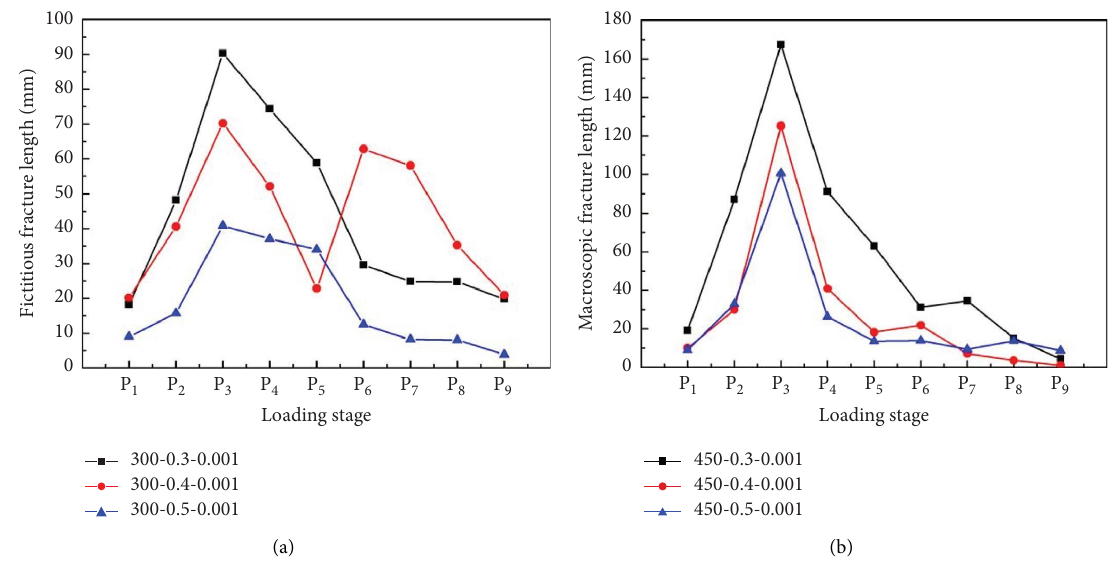
Figure 12: Variation of fctitious crack with loading stage. (a) WS300. (b)